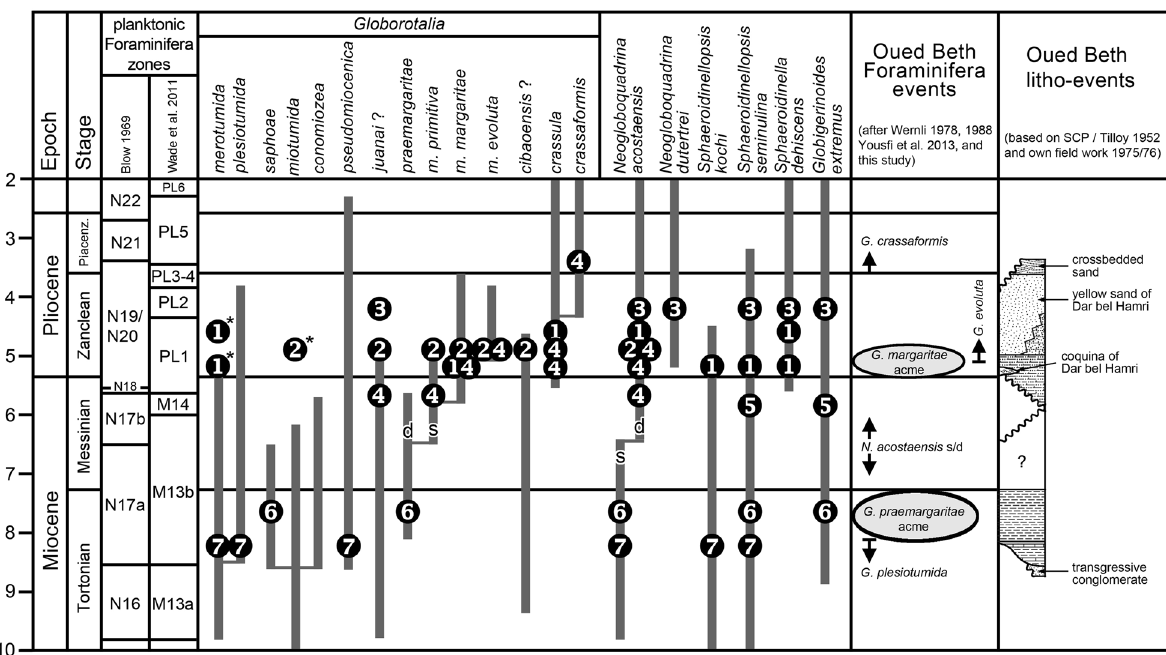
Fig. 5 Range chart of selected planktonic foraminifera observed in the study area. Ranges after mikrotax.org (2022) and Aze et al. (2011) and Maniscalco and Brunner (1998) for the Globorotalia margaritae plexus. Occurrences in studied sections and related regional biostratigraphic events mainly after Wernli (1988), Barhoun and Bachiri Taoufiq (2008) and Yousfi et al. (2013). Numbers refer to the sampled sections shown in Fig.